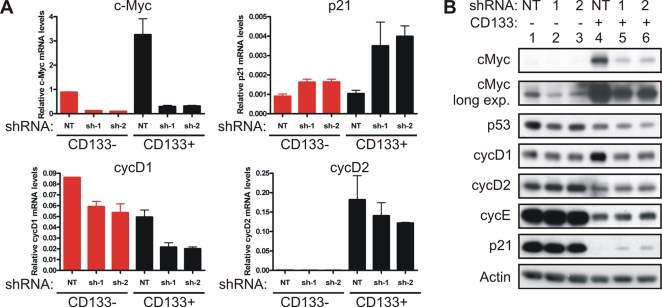
c-Myc modulates cell cycle regulators of glioma cancer stem cells.(A) Early passage (<P5) T3359 glioblastoma CD133− or CD133+ cells were infected by lentivirus directing expression of either non-targeting shRNA (NT) or c-Myc specific shRNAs (sh-1 and sh-2). The mRNA levels of c-Myc, p21WAF1/CIP1, cyclin D1 (cycD1) and cyclin D2 (cycD2) were determined by quantitative real-time PCR 3 days after infection. (B) Protein levels of c-Myc, p53, cyclin D1, cyclin D2, cyclin E and p21WAF1/CIP1 were determined by immunoblotting.